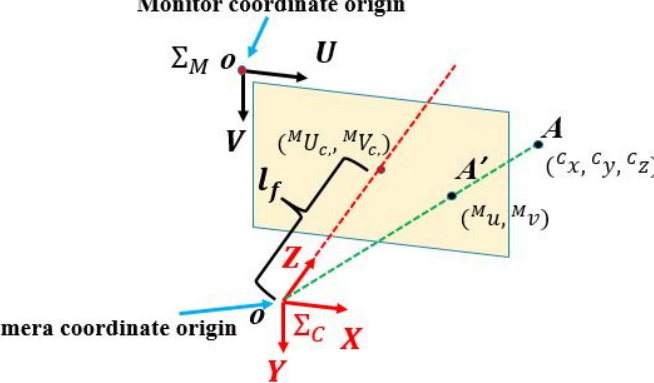
Figure 4. Image of coordinate transformation from camera coordinate to monitor